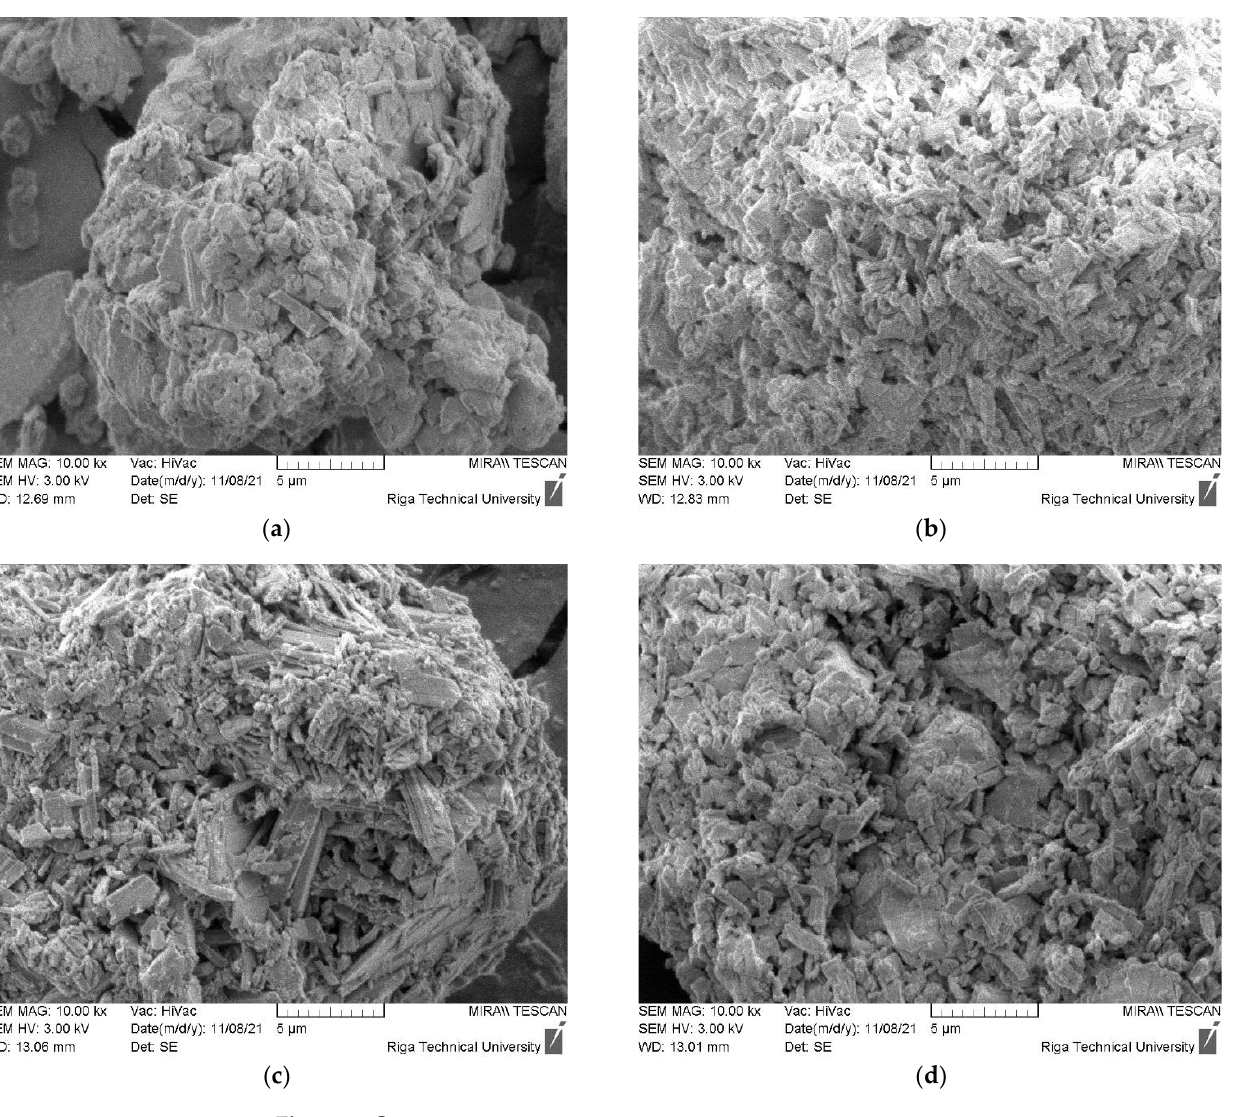
( h ) Figure 6. Morphology of CDW gypsum. ( a – d ) Untreated CDW gypsum; ( e – h ) heat treated at 180 °C for 4 h. ( a , e ) MG, ( b , f ) Type F, ( c , g ) Type H, ( d , h ) Type A.